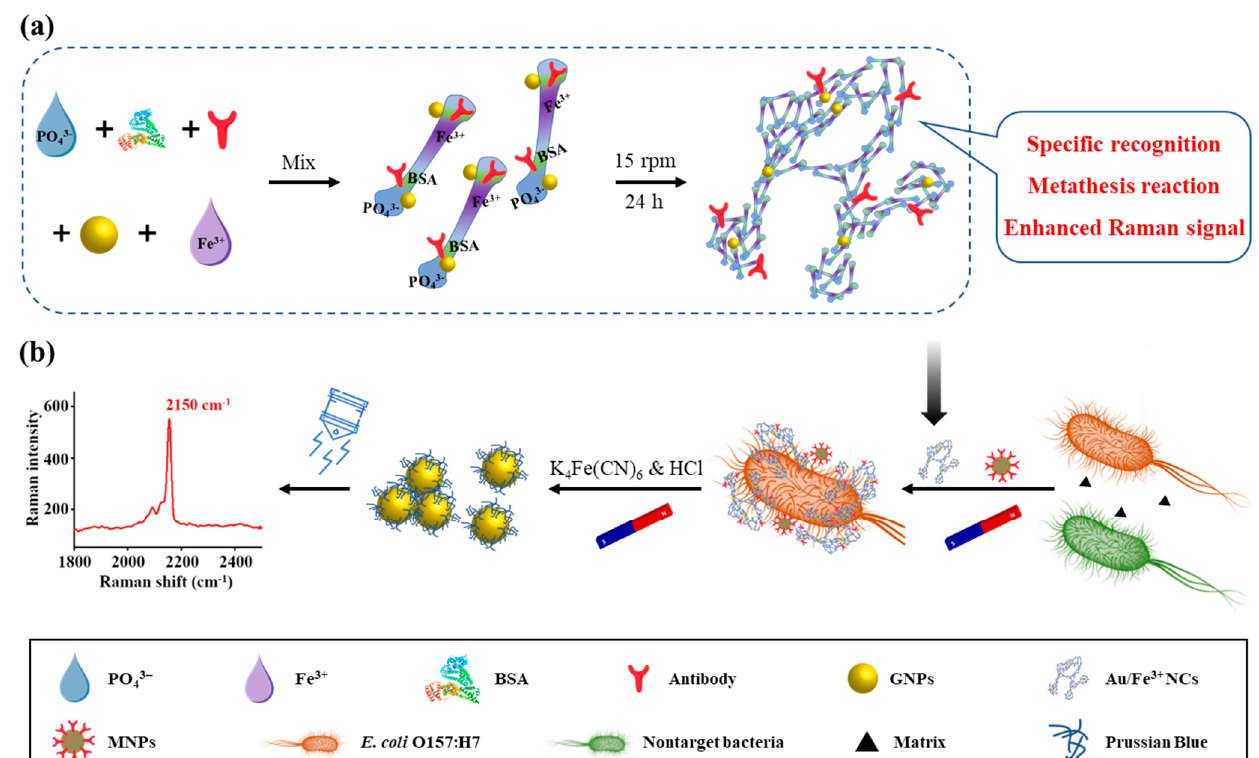
Figure 1. Schematic illustration of the SERS detection biosensor. ( a ) Principle of the one-pot synthesis of Au/Fe 3+ NCs from PBS, BSA, FeCl 3 , Au nanoparticles, and antibodies and ( b ) separation and detection of E. coli O157:H7.